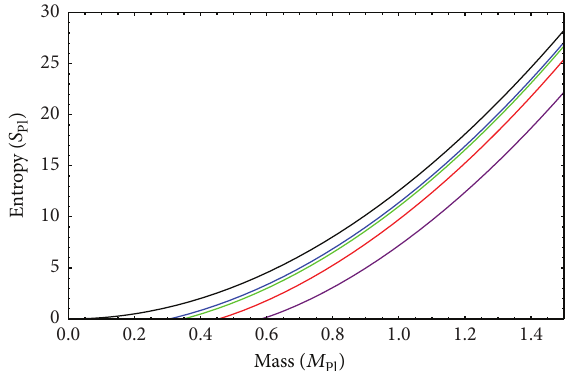
Figure 3: The entropy versus the black hole mass for the case 𝑛 = 2 . From left to right: the Hawking result (black solid curve), GUP result (solid curve), GUP 0 result (dashed curve), and GUP 1 result (dotted curve) for 𝛼 = 0.75 (red), 𝛼 = 1 (green), and 𝛼 = 1.25 (blue), respectively.